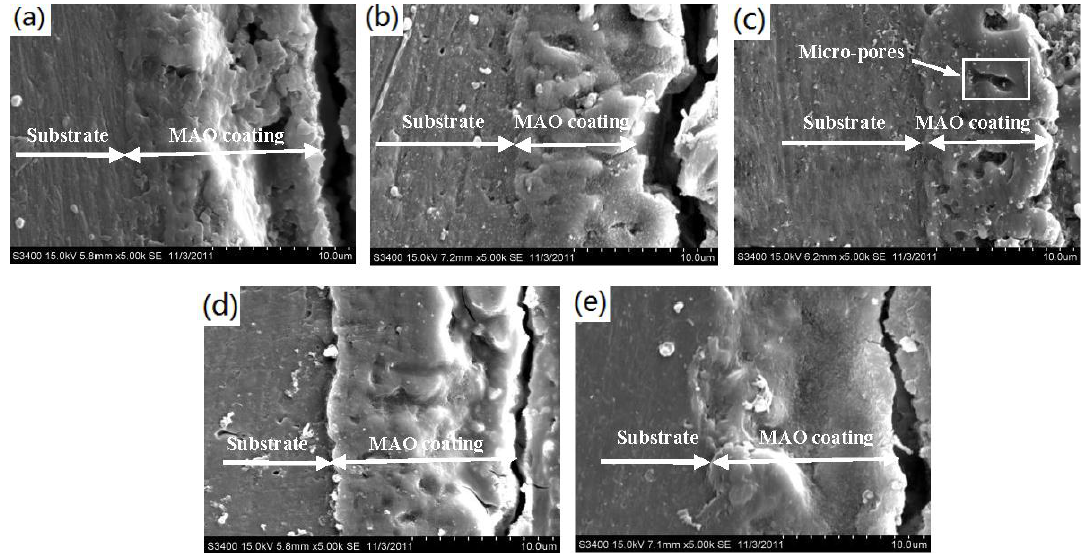
Figure 4. SEM images of the cross-section morphology of the MAO coatings on ( a ) cast AZ91D alloy and ECAPed AZ91D alloys at 523 K with ( b ) 4 passes; ( c ) 8 passes; ( d ) 12 passes and ( e ) 16 passes.